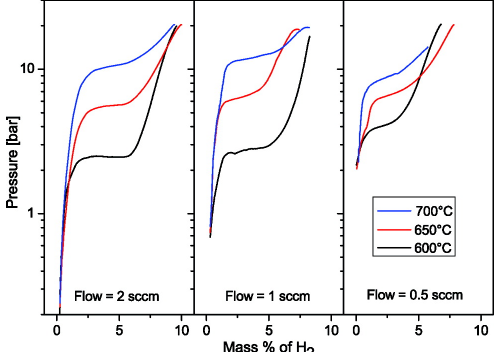
Figure 2. Pressure, composition, and temperature (PCT) isotherms measured for the thermal decomposition of NaBH 4 under a constant hydrogen flow of 2, 1, and 0.5 cm 3 (STP) min − 1 . Reprinted from